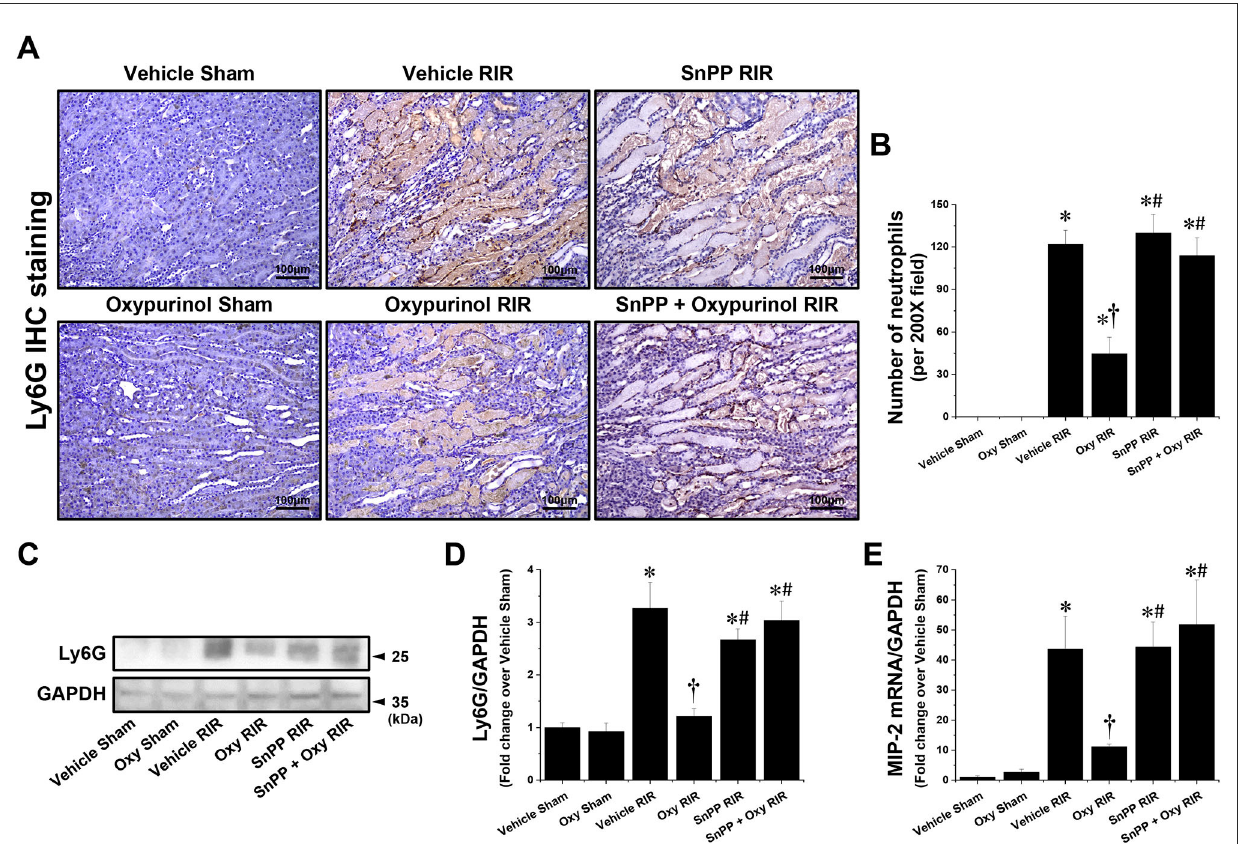
FIGURE3 Oxypurinol reduces neutrophil infiltration and Ly6G protein expression after renal ischemia/reperfusion injury. C57BL/6 male mice were subjected to sham or 30min of renal ischemia surgeries. Some mice were pretreated with 25 mg/kg of oxypurinol 24h and 1h before surgeries. Separate cohorts of mice were injected with tin protoporphyrin IX [SnPP, a heme oxygenase-1 (HO-1) inhibitor, 25 mg/kg, Tocris Bioscience] 30min before oxypurinol first treatment. (A) Representative images (magnification, 200 × ) of immunohistochemistry staining in the post-operative kidneys show infiltrated neutrophils (dark brown), and (B) the Ly6G-positive cells were counted. (C) Kidney samples were subjected to Western blotting using an anti-Ly6G antibody. GAPDH was used as a loading control. (D) Band intensities were measured using ImageJ. (E) With quantitative RT-PCR, we measured the mRNA expression of MIP-2, which was normalized to GAPDH mRNA expression. Results are expressed as means ± SEM (vehicle or oxypurinol [oxy] sham n = 4; vehicle, oxypurinol, SnPP, or SnPP + oxypurinol RIR n = 6). * P < 0.05 vs. vehicle sham; † P < 0.05 vs. vehicle RIR; # P < 0.05 vs. oxypurinol